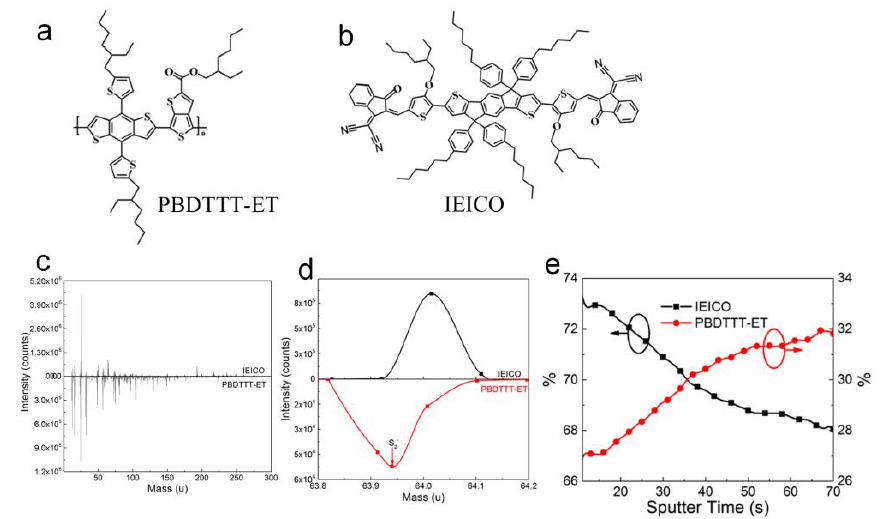
Figure 1. Molecular structures of ( a ) PBDTTT-ET and ( b ) IEICO; ( c ) distribution maps of elements within IEICO and PBDTTT-ET; ( d ) local enlarged drawing of distribution maps in ( c ); ( e ) depth profiles of IEICO and PBDTTT-ET in the blend film.